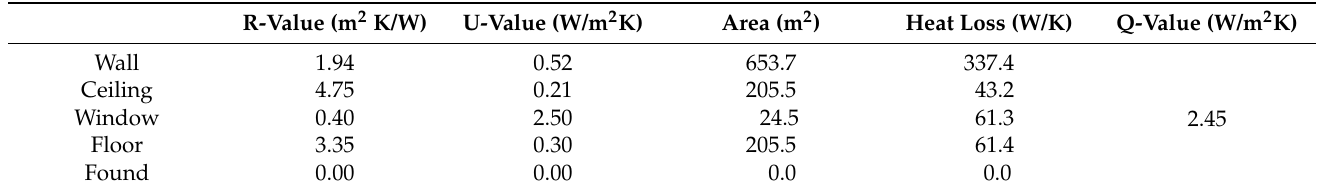
Table 6. R-value and Q-value conversion results (post-1980 vintage for the southeast